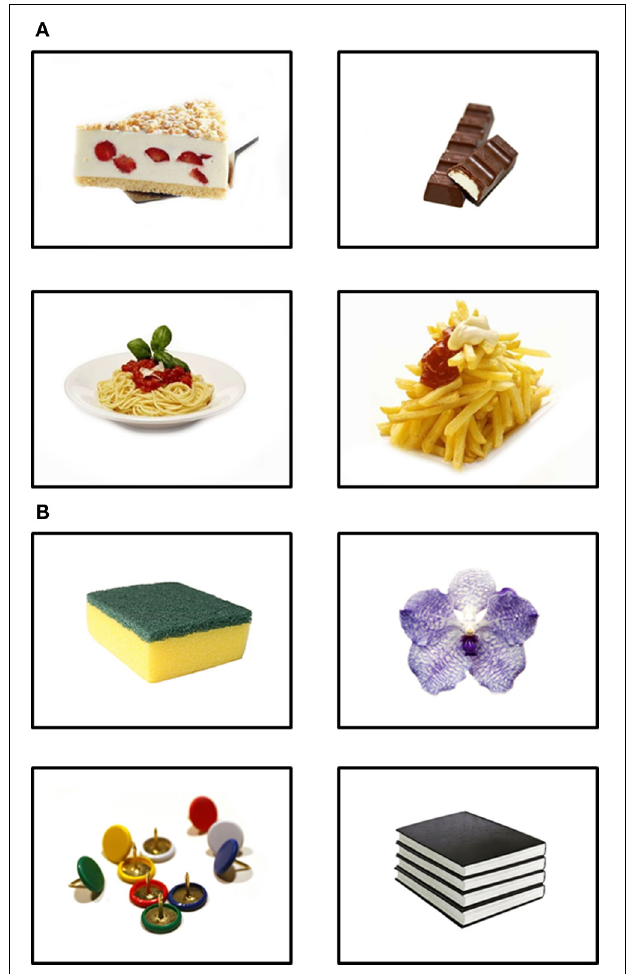
FIGURE 2 | Exemplary pictures of (A) food and (B) neutral items used in study 2.